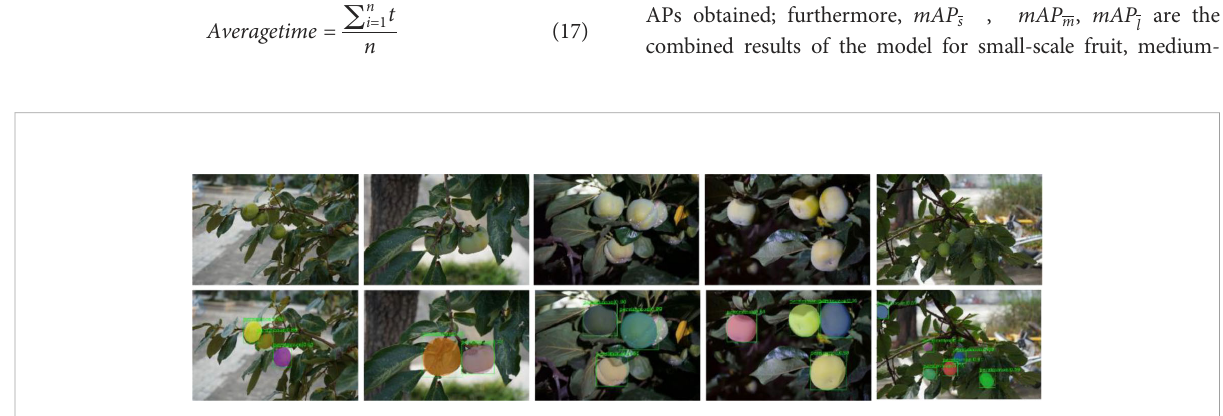
FIGURE 8 Effect of segmentation on unripe persimmon(The fi rst row represents the original data set, and the second row shows the effect after segmentation by Polar-Net